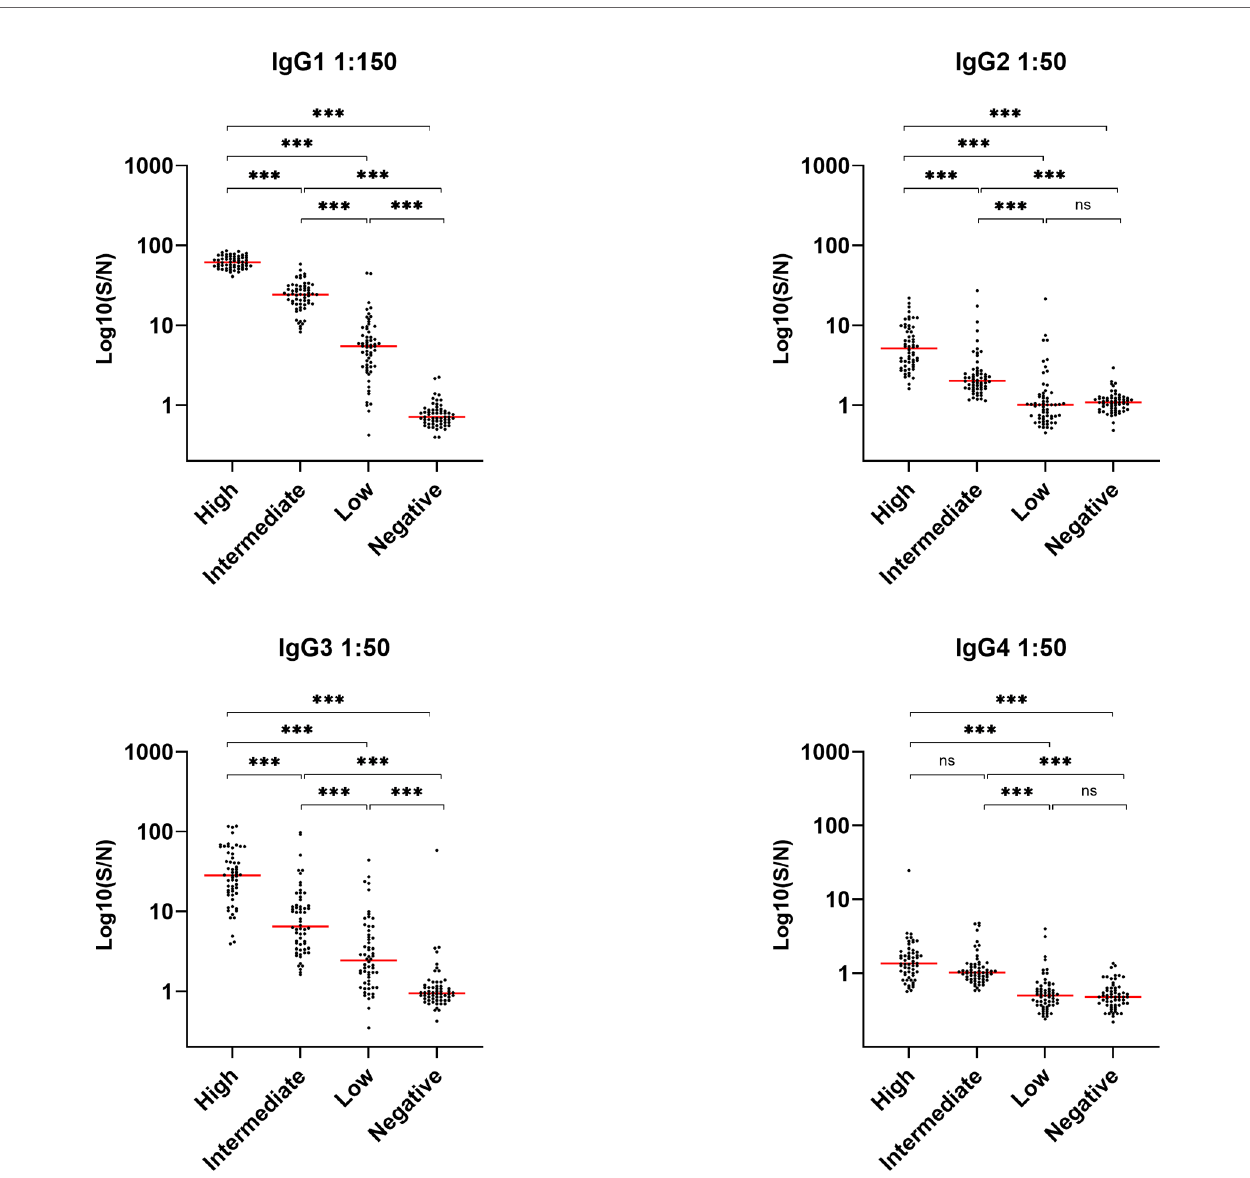
FIGURE 1 | Detection of IgG1, IgG2, IgG3 and IgG4 in recovered SARS-CoV-2 individuals. Groups divided according to levels of total IgG; high, intermediate, low and negative healthy controls, n = 240. Levels were assessed by coating plates with 1 µg/nm RBD and detecting with HRP-conjugated antibodies against IgG1, 2, 3 and 4 (1 µg/ml). Samples were measured in a 1:50 dilution, except for IgG1 which were measured in a 1:150 dilution. Dynamic range represented in signal-to-noise ratios (S/N). A p value < 0.05 was considered signi fi cant. ns, not signi fi cant, ***p < 0.001 using Tukey all-pair